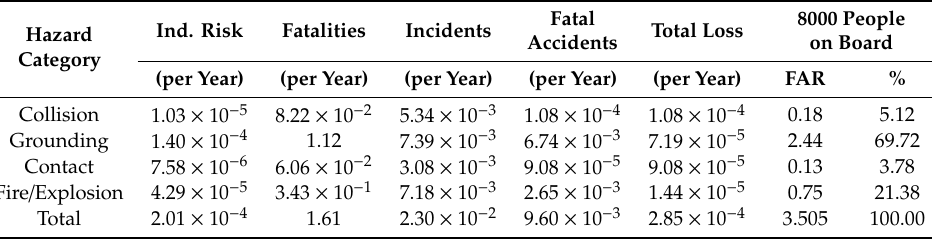
Table 15. Overall risk calculation for all passenger ships.